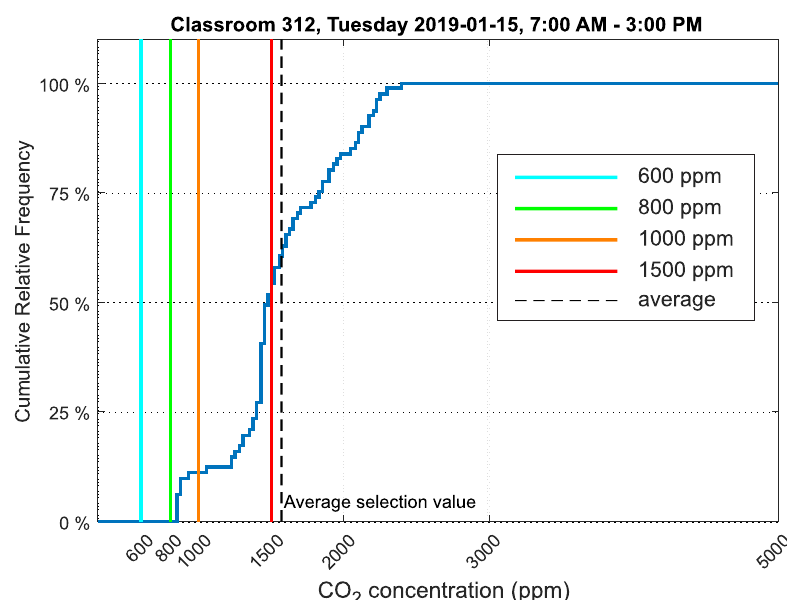
Figure 18. Cumulative relative frequency graph of the data selection showing CO 2 concentration in classroom 312, Frenštát pod Radhoštˇem.